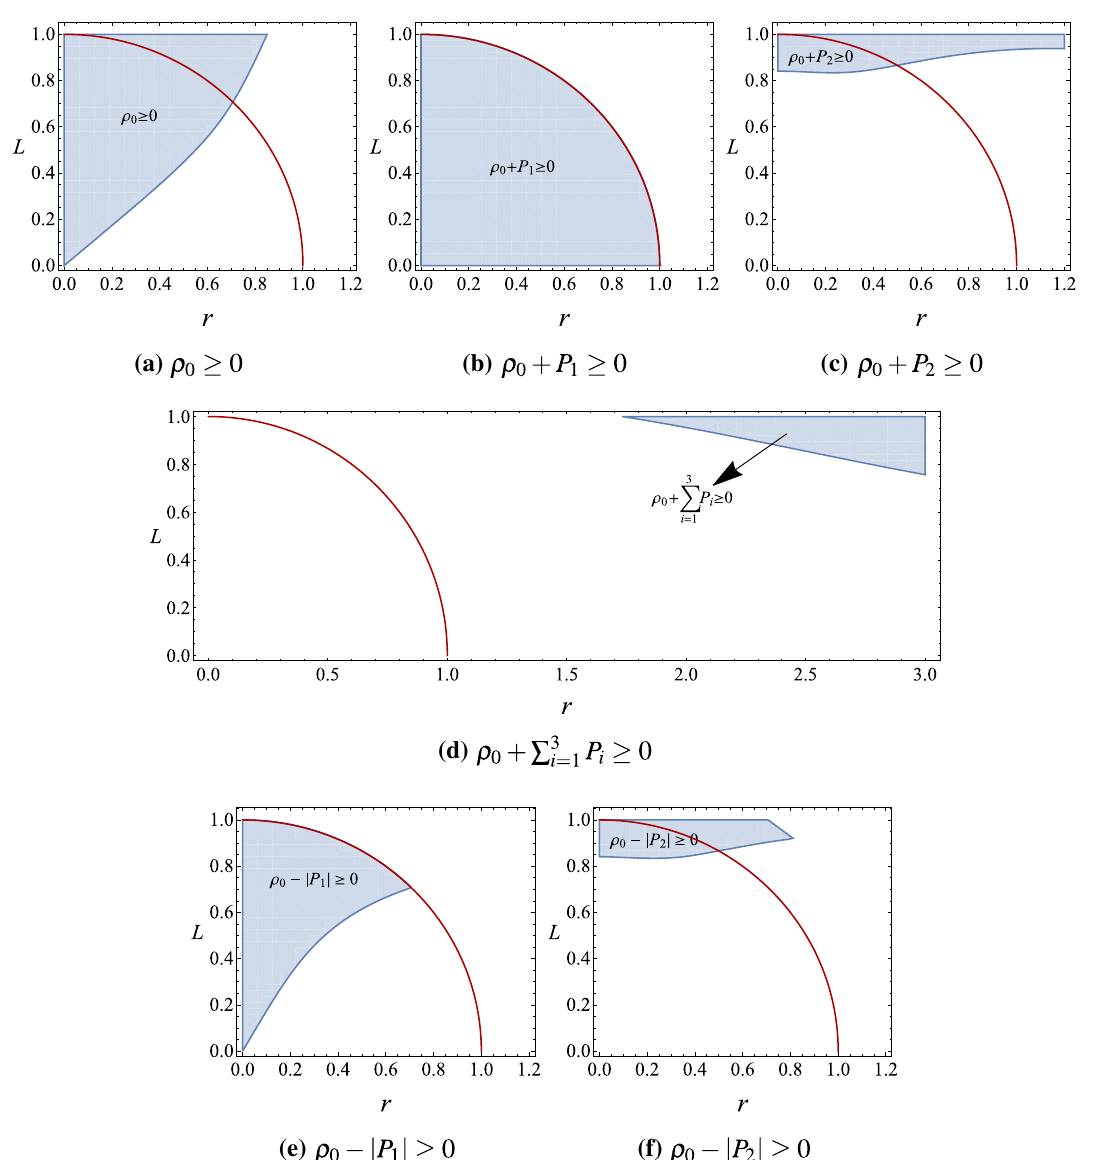
Fig. 5 The blue shadows show the physical regions in which the corresponding inequalities are satisfied for the case of N = 1 / 2, where the red curves are horizons. Note that the existence of horizons gives the constraint, L 2 < 1, in this